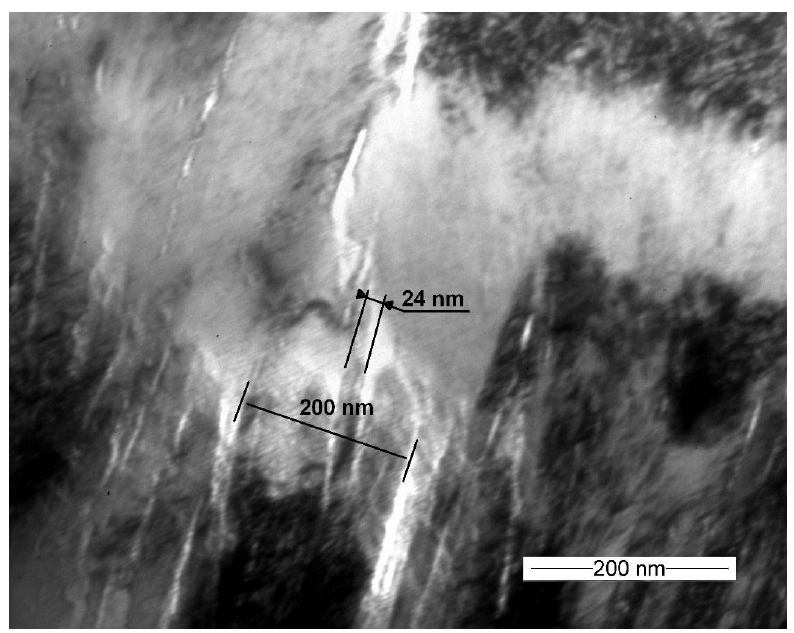
Figure 5. Bright-field image of the Cr 2 AlC coating deposited at 2.5 kW sputtering power, showing column width and nanoscale subgrains. Metals 2016 , 6 , 265